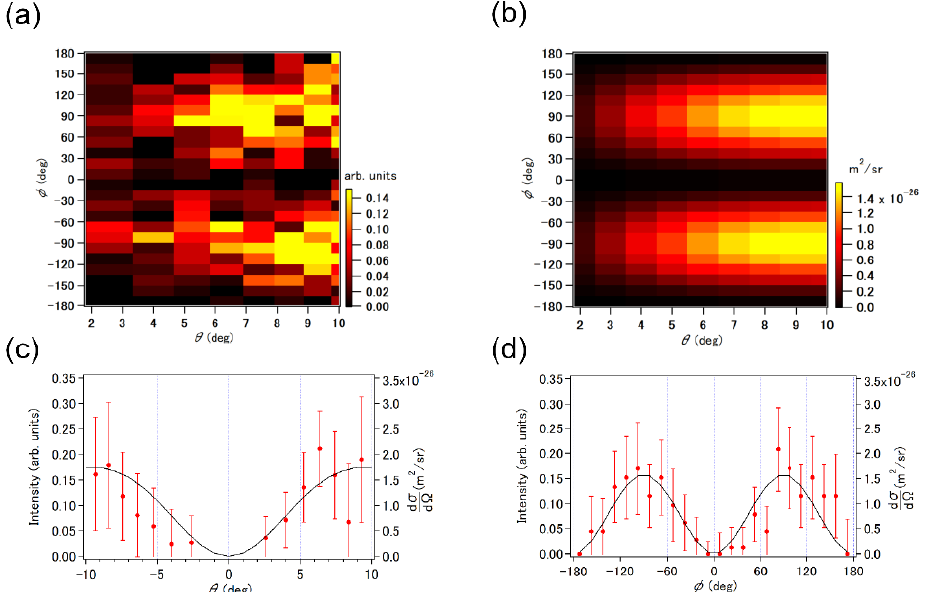
Figure 10. Angular intensity distributions of the LAES signals ( n = +1) with an Ar gas: ( a ) Experimental two-dimensional plot. ( b ) Simulated two-dimensional plot. ( c ) Experimental (red filled circles) and simulated (black solid curve) cross sections at ϕ = ±90°. The positive and negative ranges of θ correspond to ϕ = +90° and ‒90°, respectively. ( d ) Experimental (red filled circles) and simulated (black solid curve) cross sections at θ = 9.3°.